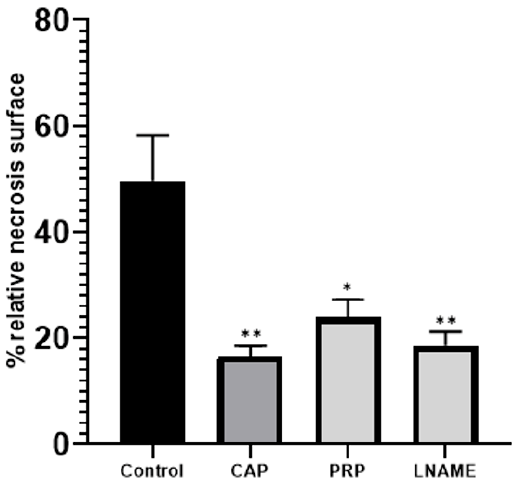
Figure 2. Relative necrosis surface (%) from the entire flap surface as determined by photo analysis. Dehiscent and prenecrotic surfaces were included into the necrosis area. * p < 0.05; ** p < 0.01.